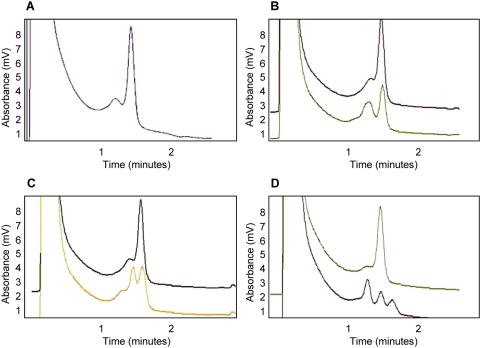
Mutation detection in the T4_promoter fragment.Three polymorphisms were detected by dHPLC in the T4_promoter fragment and were verified by DNA sequencing. The four dHPLC graphs correspond to the wild-type sequence (A), SNPs T-441C (B), SNP A-271G (C) and SNP G-259C (D). The wild-type pattern is visible in all dHPLC graphs as a 1 peak trace. SNP T-441C is identified by an unequal height 2 peak trace (B), SNP A-271G is identified by an equal height 2 peak trace (C) and SNP G-259C is identified by a 3 peak trace (D). The positions of the sequence variants in the T4_promoter fragment identified by dHPLC were determined by DNA sequencing. All SNPs were present in the heterozygous state.